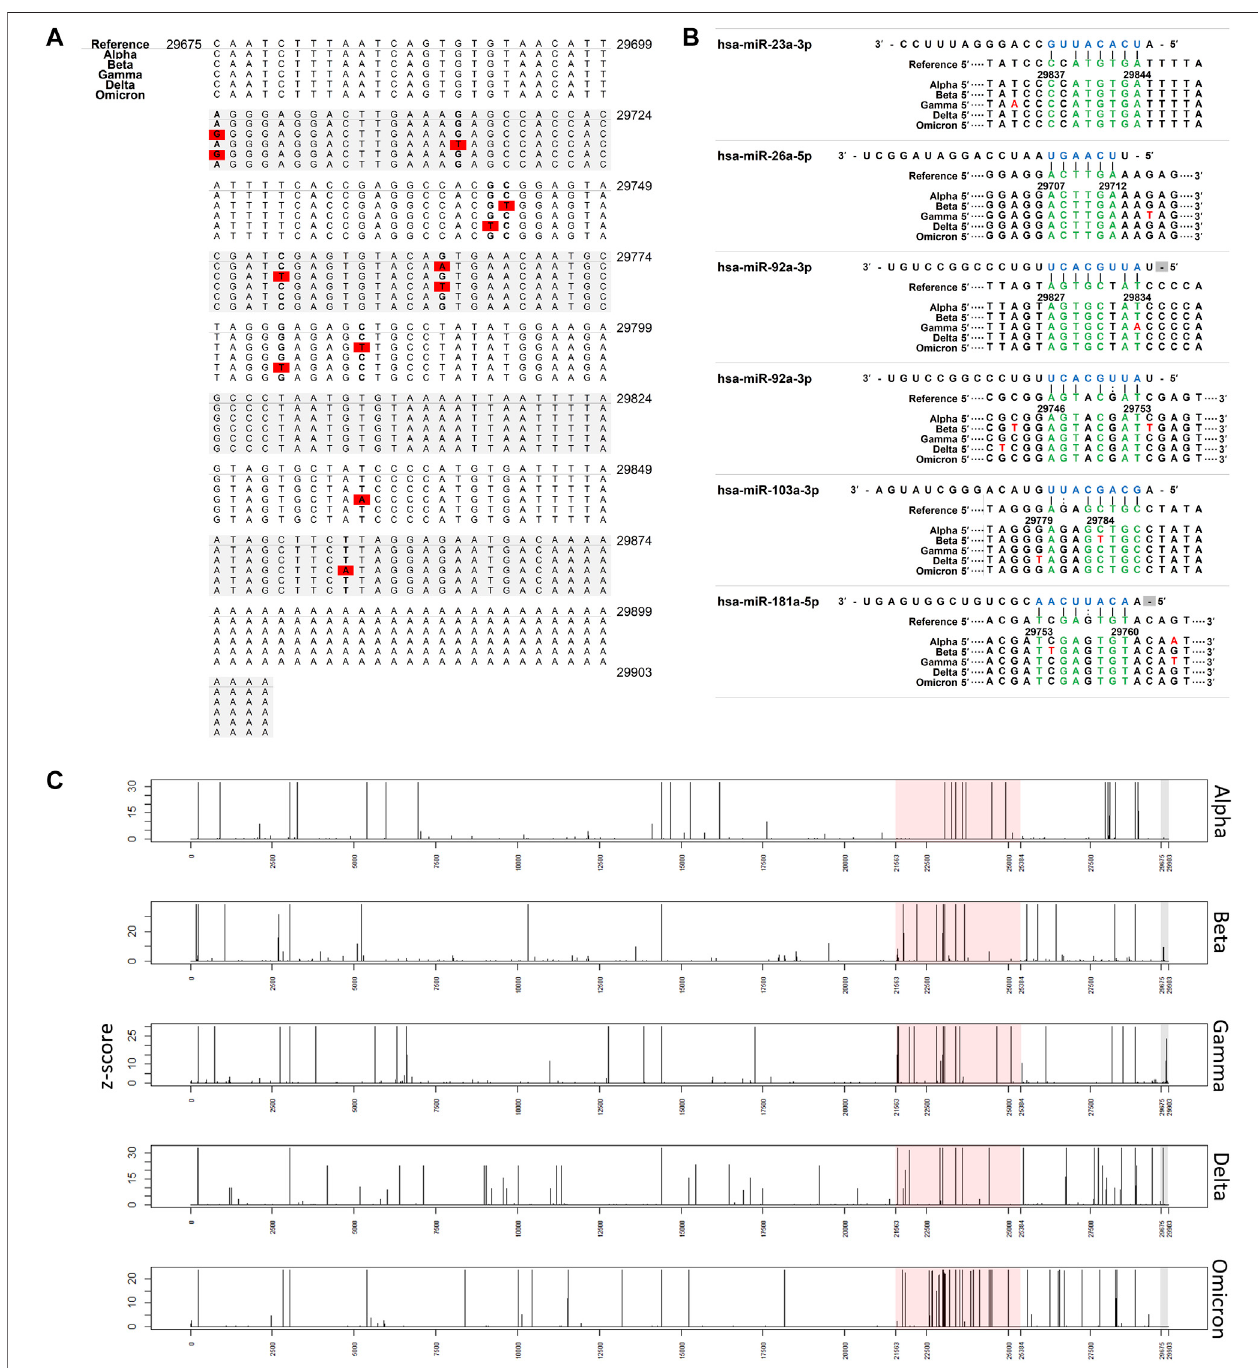
FIGURE1| InteractionofmiRNAsonSARS-CoV-23 ′ UTRs. (A) Nucleotidechangein3 ′ UTRofSARS-CoV-2Red:nucleotidechanges(associatedwith Table2 ). (B) miRNAbindingsitein3 ′ UTRofSARS-CoV-2.Nucleotidechangesobservedmorethan1%werepresented. (C) Plotshowingthefrequencyofnucleotidechangesin the SARS-CoV-2 genome. The frequency was scaled by the z-score within each variant. Red shading indicates spike glycoprotein coding region and grey shading indicates the 3 ′ UTR region.